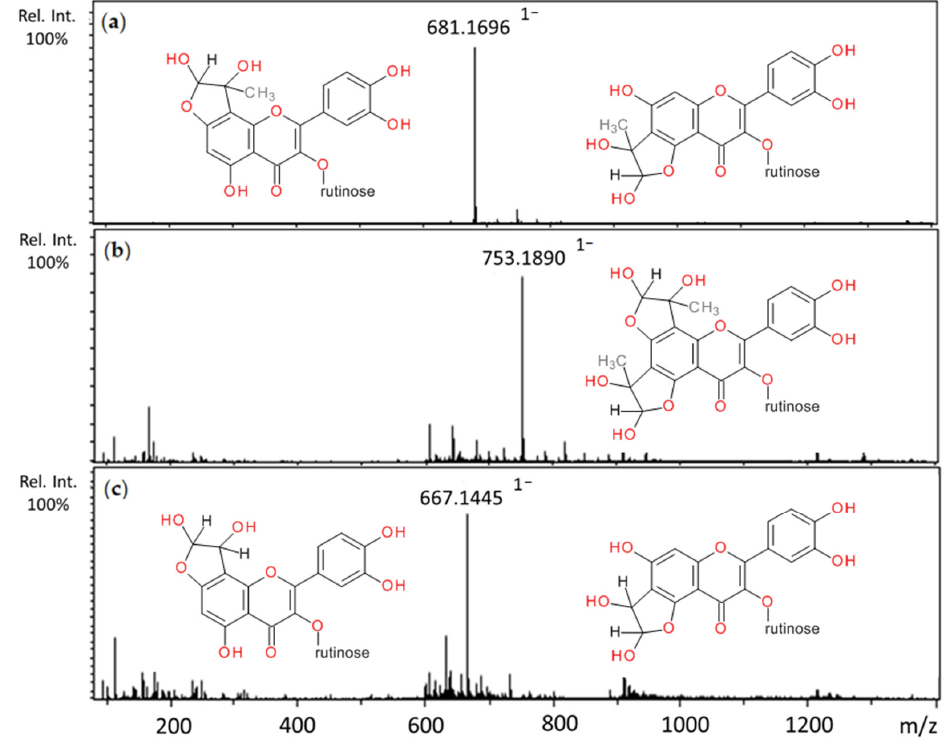
Figure 4. Mass spectra of methylglyoxal and glyoxal adducts with rutin after 1 h incubation in pH 7.4 phosphate buffer solution at 37 °C and their proposed chemical structure: ( a ) mono-MGO-rutin; ( b ) di-MGO-rutin; ( c ) mono-GO-rutin; other isomeric forms are also possible.